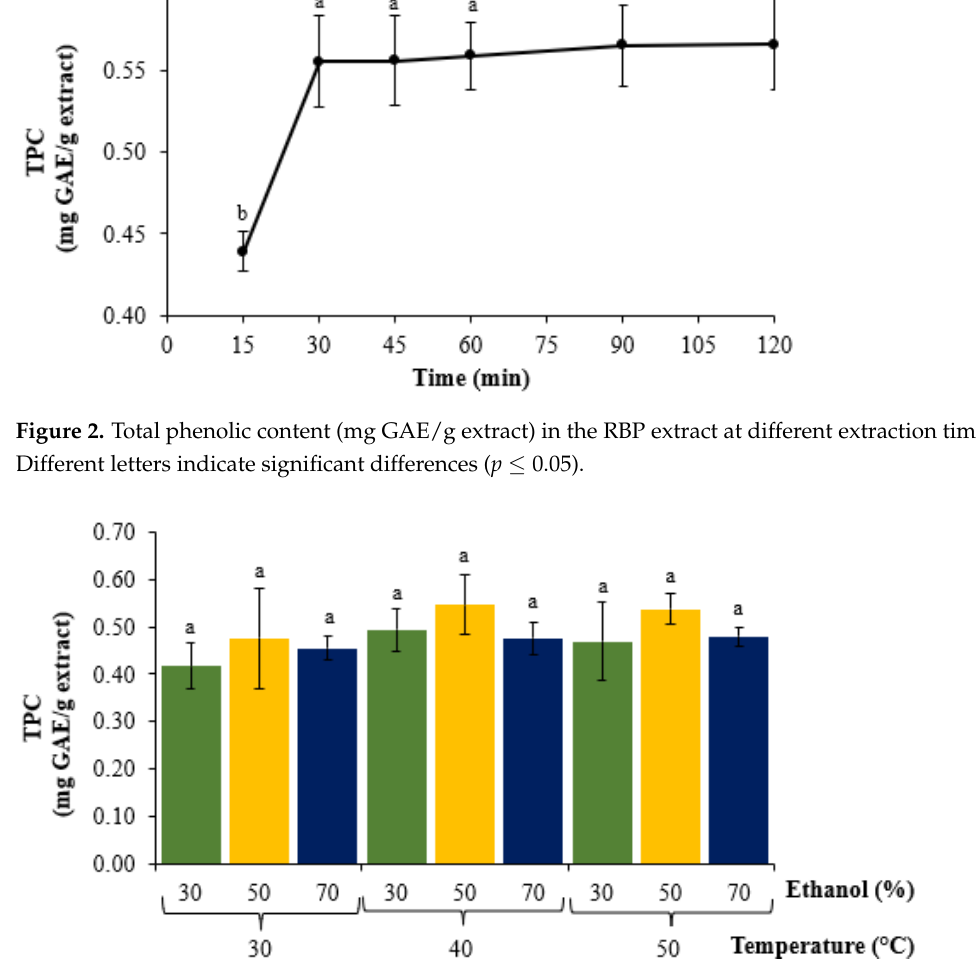
Figure 3. Total phenolic content (mg GAE/g extract) in the RBP extract at different temperatures and solvent concentrations. Same letters are not significantly different ( p ≤ 0.05).